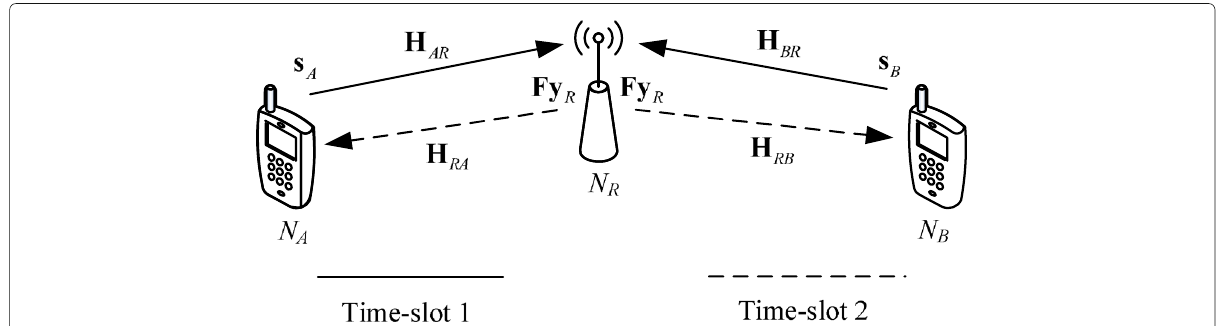
Fig. 1 A TWR network, where two sources N A and N B deliver data to each via a relay node N